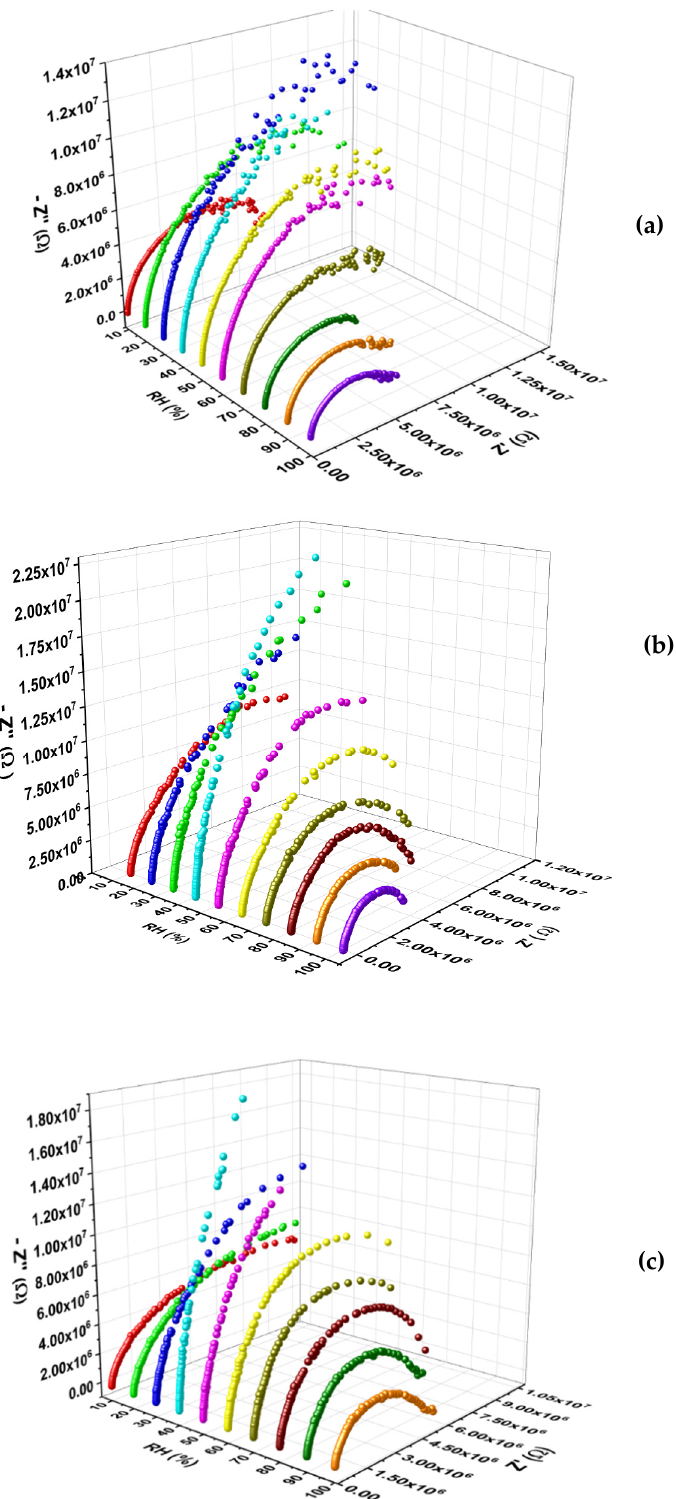
Figure 6. Nyquist Plot of the MOHN obtained samples as a function of RH, in the frequency range from 400 Hz to 40 MHz, for the ( a ) TW, ( b ) TW − Zn 2, and ( c ) TW − Zn 4. Adsorption of ions from moisture becomes dominant above 30–40% RH in the tested MOHN , allowing the electrons to return to the conduction band and thus defining the transition from p- to n-type conduction in these